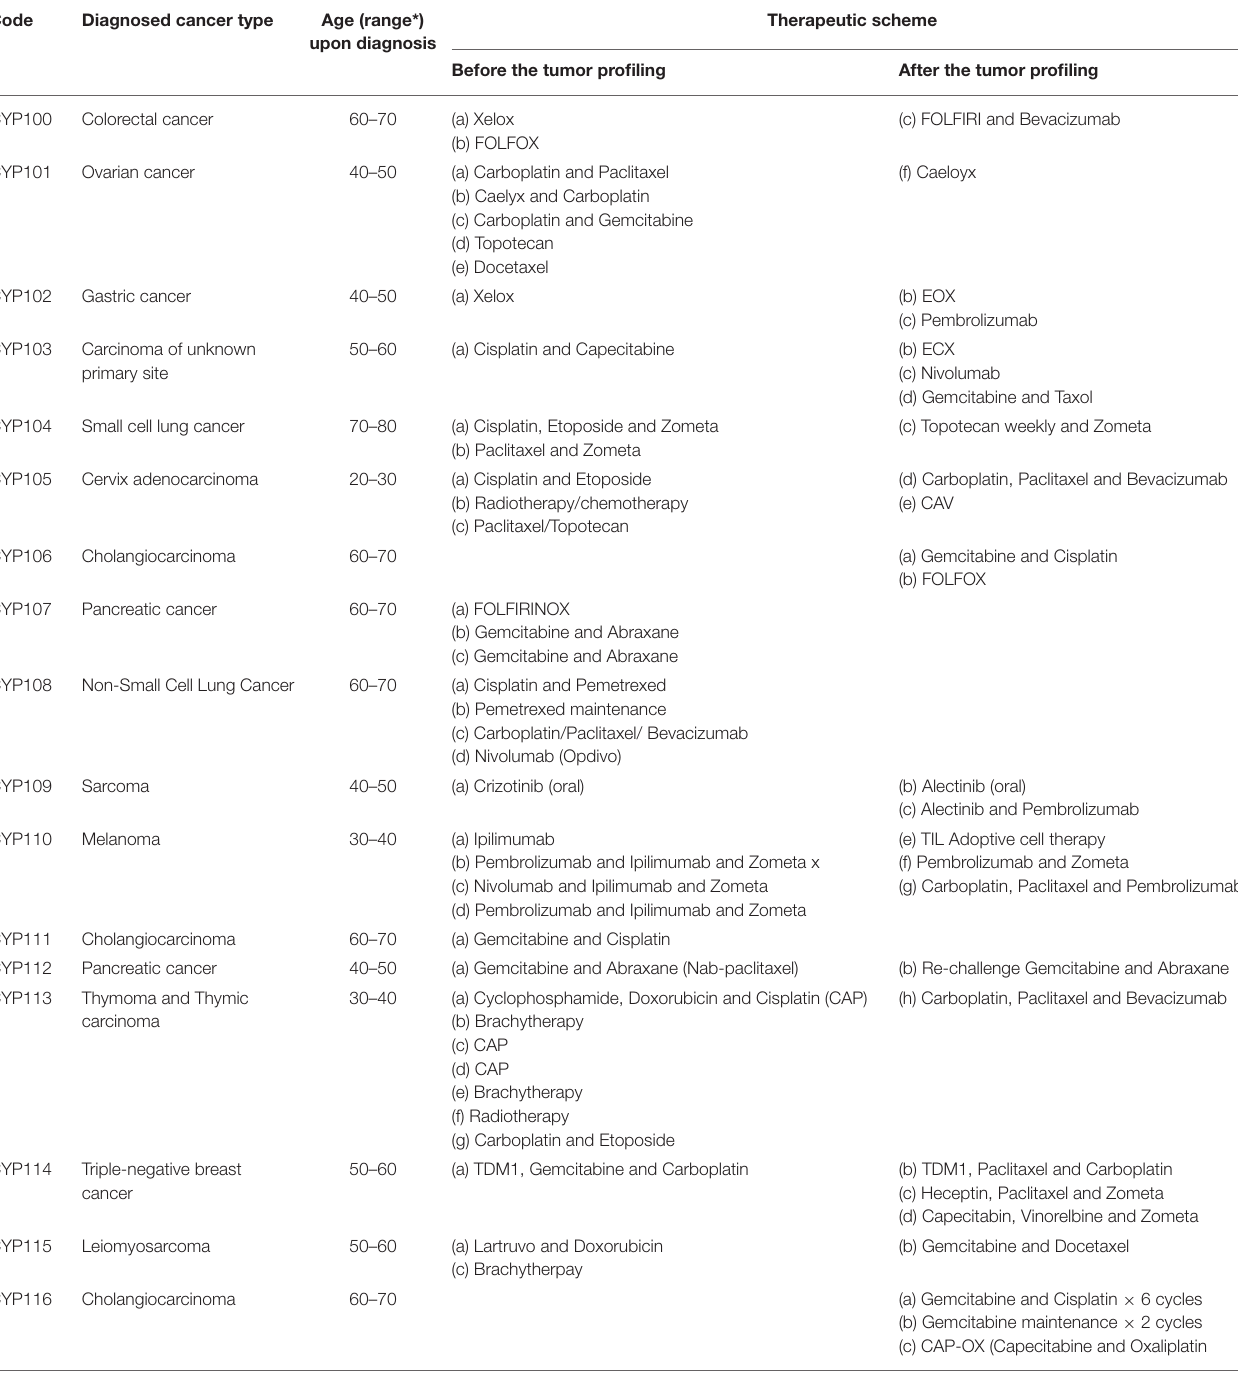
TABLE 1 | Patient information concerning personal information, malignancy type, and treatments